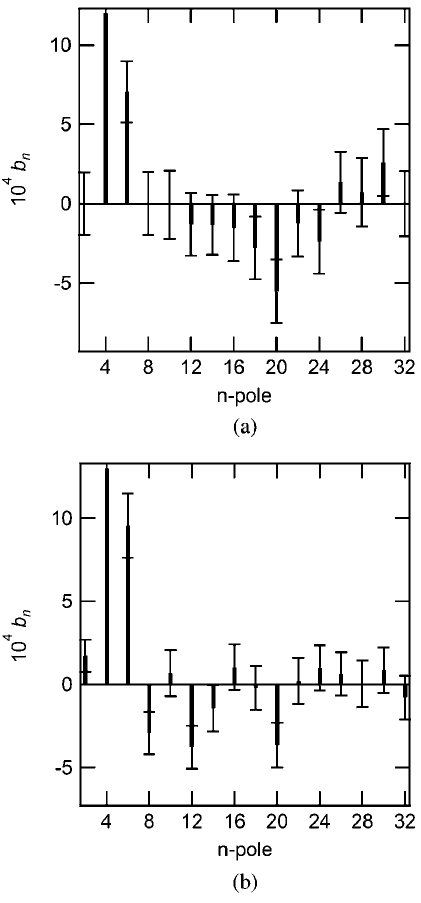
FIG. 13. Measured normal multipole content of a quadrupole magnet: (a) circular trajectory; (b) 4PCT. The quadrupole com- ponent has been normalized to one.